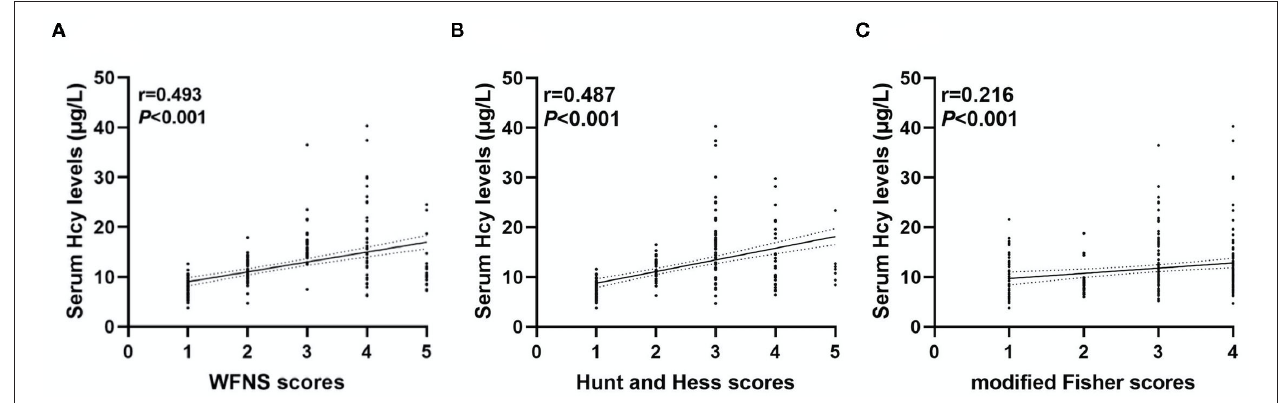
FIGURE 3 | Correlation between serum homocysteine (Hcy) levels and clinical severity. Serum Hcy levels had a positive relationship with the World Federation of Neurosurgical Societies (WFNS) scores (A) , Hunt and Hess scores (B) , and modified Fisher scores (C) .